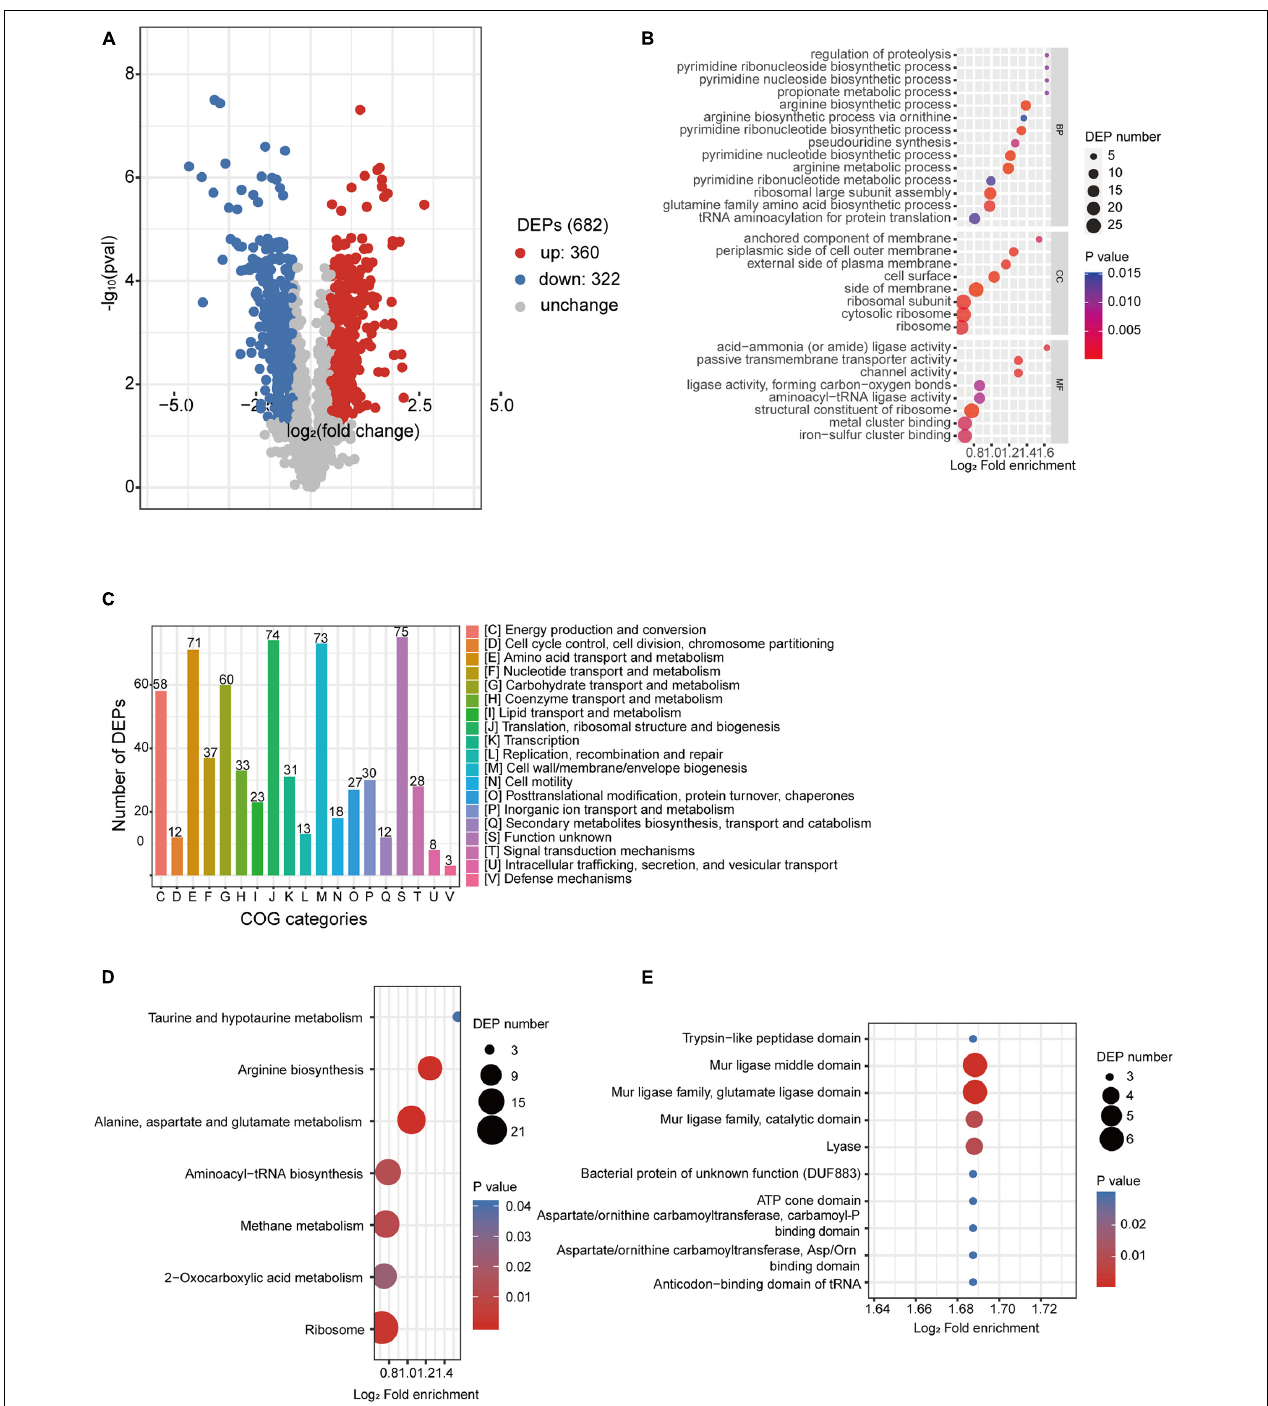
FIGURE 5 | Proteomic analysis of desiccated C . sakazakii G4023. (A) Volcano plots of upregulated and downregulated ( ≥ 1.5-fold) proteins in desiccated C . sakazakii G4023. The red dots represent upregulated proteins, blue dots represent downregulated proteins, and gray dots represent no significantly differentially regulated protein. (B) COG analysis of DEPs. Bars represent the number of DEPs in each COG category. Besides the ones with unknown function, DEPs were categorized mostly in translation, ribosomal structure, and biogenesis, followed by in cell wall/membrane/envelope biogenesis and amino acid transport and metabolism. (C) Significantly enriched GO terms of DEPs in desiccated C . sakazakii G4023; 14 terms belong to BP, 8 terms belong to CC, and 8 terms belong to MF. (D) Seven KEGG pathways of DEPs were significantly enriched in desiccated C . sakazakii G4023. (E) Ten protein domains of DEPs were significantly enriched in desiccated C . sakazakii